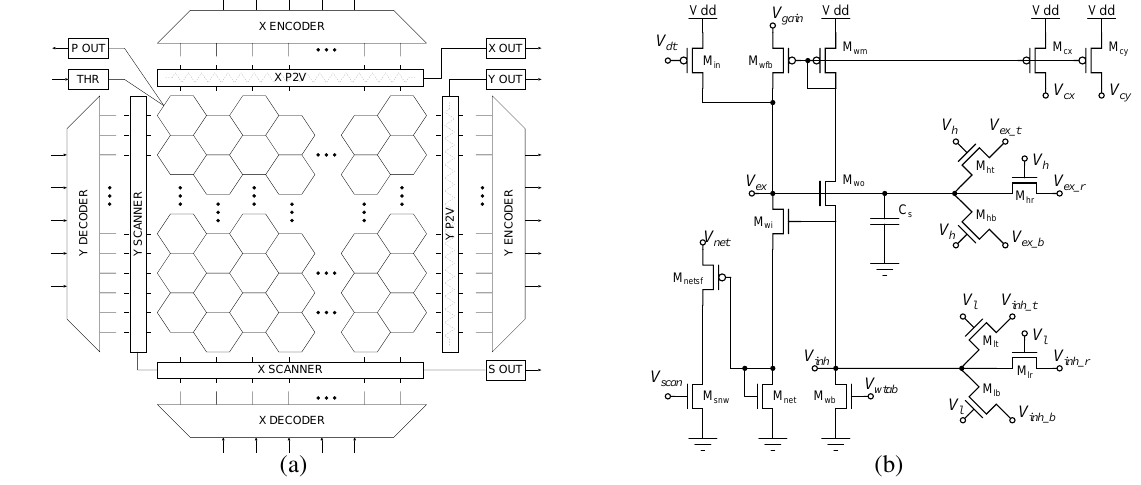
Figure 7 . (a) The two-dimensional tracker chip architecture. (b) Circuit diagram of a two-dimensional hysteretic WTA